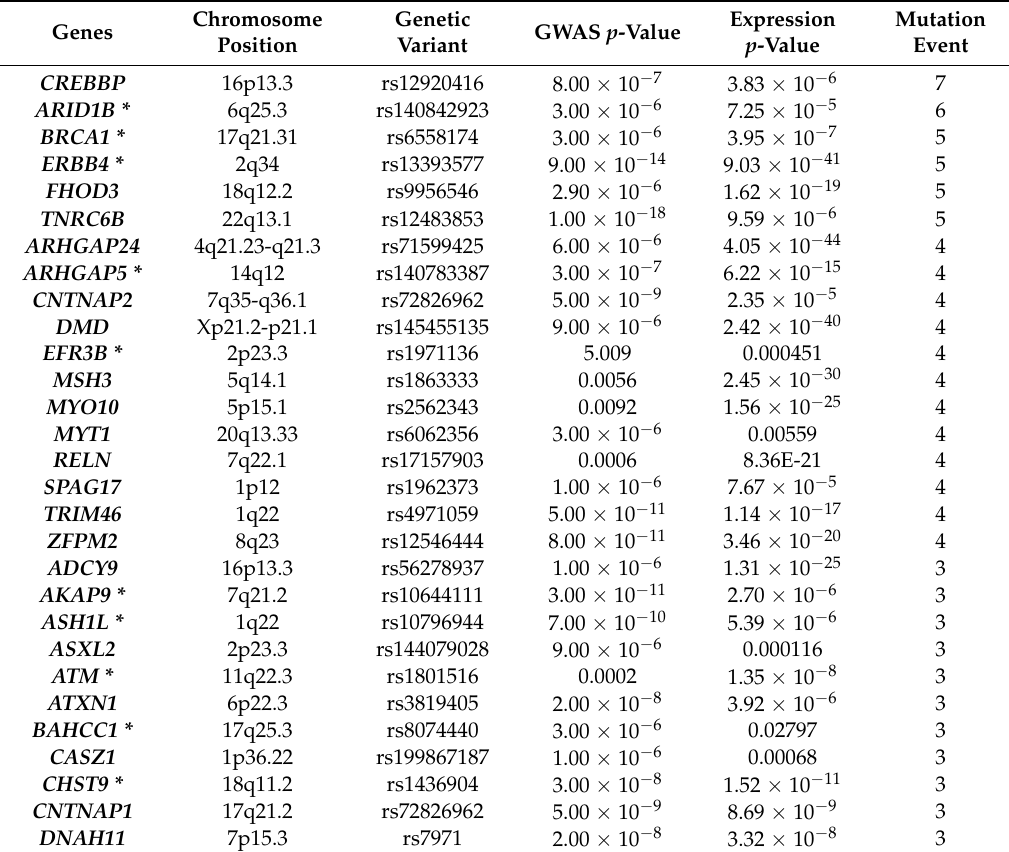
Table 2. The 29 genes signature of the most highly significantly differentially expressed genes containing both germline and somatic